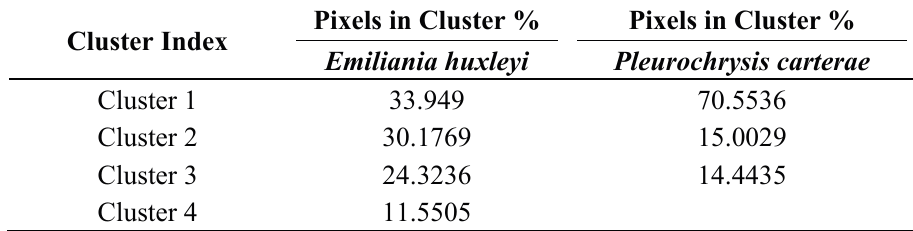
Table 1. Total Ca of pixels in cluster percentages in coccoliths by cluster measurements of images as showed in Figures 3 and